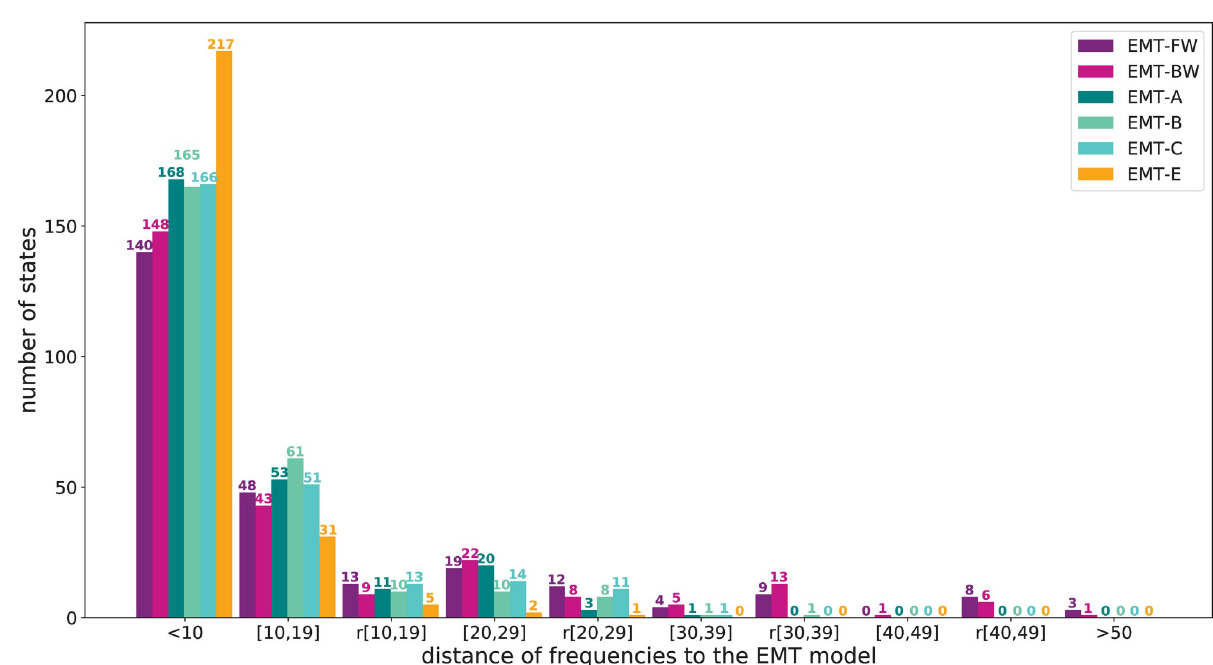
Fig 6. Accuracy of the steady state frequencies in relation to the EMT-O. The categories on the x-axis are in reference to the distance of the frequencies resulting from the EMT model over all states that converge to 2 steady states. In category < 10, all states are counted that are within a distance of 10% of the frequencies resulting from EMT-O. Category (10, 19) counts the number of states that are within a distance of 20% from the results from EMT-O with the same qualitative behavior. In category r(10, 19), we count the number of states that are within a distance of 20% from the results from EMT-O that also have a reversed qualitative behavior. Categories (20, 29) and r(20, 29) count the number of states that are within 30% of the EMT states with the same qualitative behavior, and the reversed qualitative behavior respectively, similar to categories (30, 39), r(30, 39), (40, 49), and r(40, 49). In category > 50, we count all the states that are more than 50% away from the EMT-O frequencies.